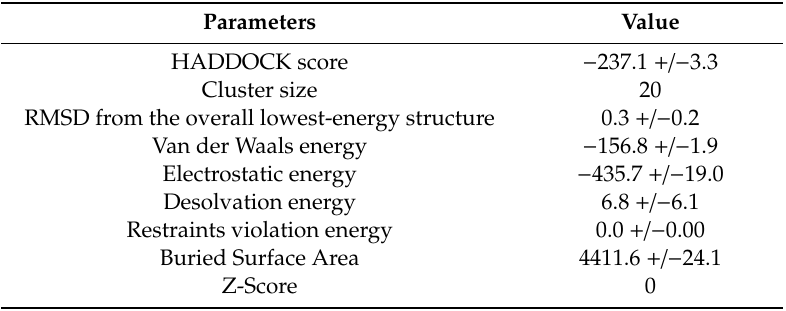
Table 1. Table showing statistics of top vaccine-TLR2 docked cluster. Statistics of top ranked vaccine-TLR2 cluster are shown. Lower HADDOCK score signifies strong interaction between proteins.